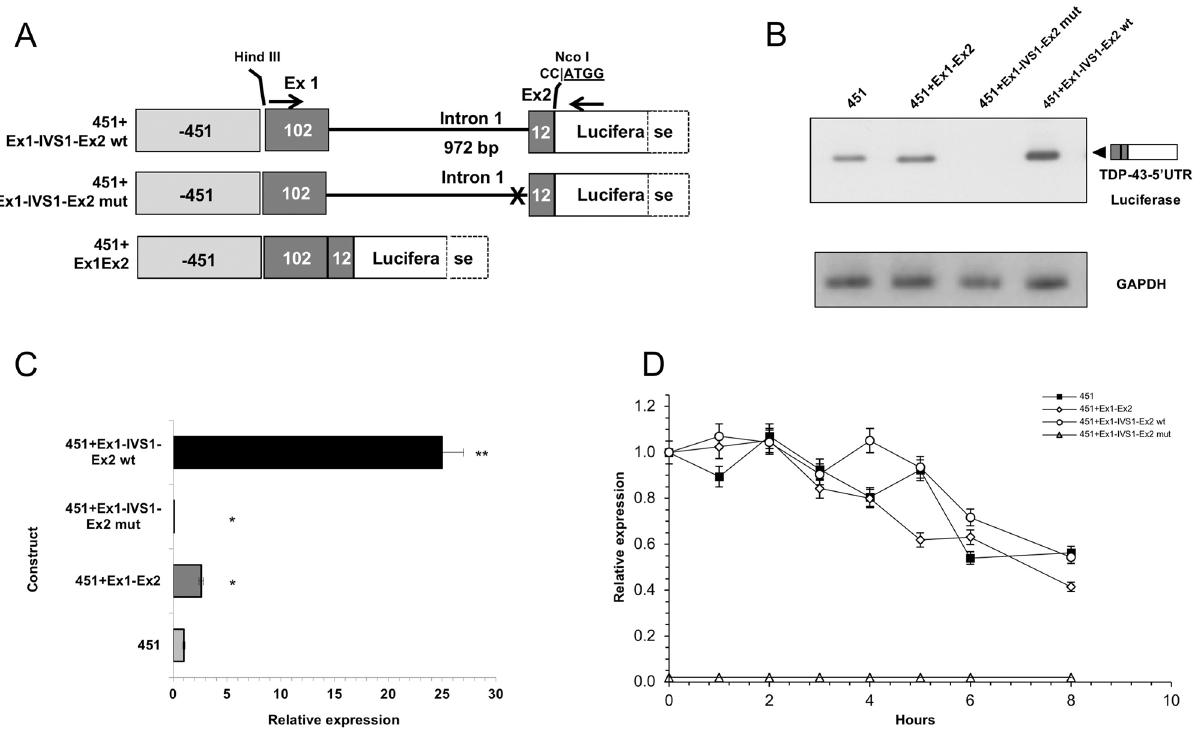
Figure 8. Effects of 5 ′ UTR and intron 1 on the transcriptional activity of the human TARDBP promoter. ( A ) Diagrams of the 5 ′ UTR TDP-43 constructs generated using the pGL-451 vector. In the 451 + Ex1-IVS1-Ex2 wt construct, the 1086 bp genomic region of the human TARDBP gene spanning the 5 ′ UTR, including Exon 1 (102 bp), Intron 1 (972 bp) to the first 12 nt of Exon 2) was (Hind III-Nco I) cloned in between the 451nt-promoter and the firefly luciferase ORF (Luciferase). In the 451 + Ex1-IVS1-Ex2 mut construct, the 3 ′ splicing site of Intron 1 was deleted. In the 451 + Ex1Ex2 construct, the fragment encompassing Exon 1 and Exon 2 (without Intron 1) was cloned in the 451 vector. ( B ) RT-PCR of the 5 ′ UTR TDP-43 mRNA species (upper panel). Amplification of GAPDH (lower panel) was used as the endogenous control in the quantitative analysis of RT-PCR. ( C ) Quantitation of the 5 ′ UTR TDP-43 mRNA species by Real Time PCR. GAPDH was used to confirm normalization of total RNA levels. Co-transfected renilla orf was used to normalize the luciferase qPCR. The 451 construct was used as reference (= 1). ( D ) Effects of transcriptional inhibition on mRNA stability. After 36 h post-transfection of the luciferase (451 + Ex1-IVS1-Ex2 wt and 451 + Ex1-IVS1-Ex2 mut) constructs, SH-SY5Y cells were treated with actinomycin D 5 µg/ml. The relative levels of the indicated mRNAs (wt and mut) were assessed at the designated time points, following shutoff of transcription using qRT-PCR to determine mRNA half-lives. The average half-lives are reported with SD from two independent experiments. Significance values refer to comparisons against t = 0 h, wt: *p < 0.05 (one way ANOVA with Tukey test). The mean values for 451 + Ex1-IVS1-Ex2 mut construct were negligible and did not differ to a statistically significant extent (p ≥ 0.05).